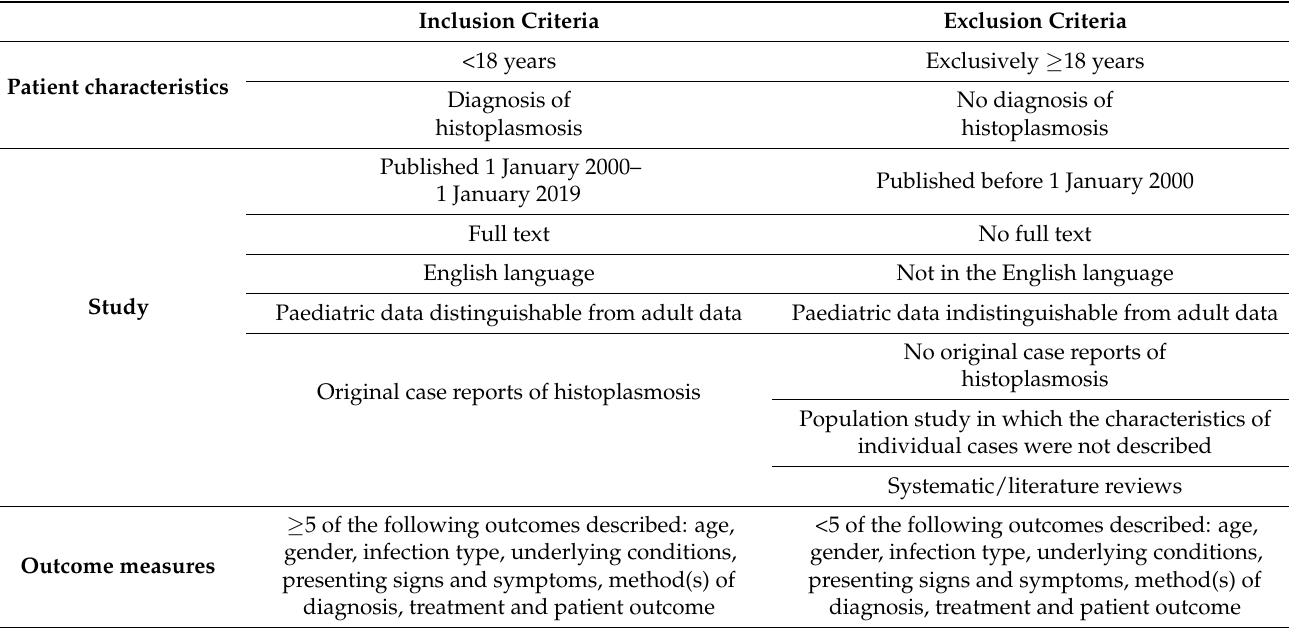
Table 1. Inclusion and exclusion criteria that were used in the literature